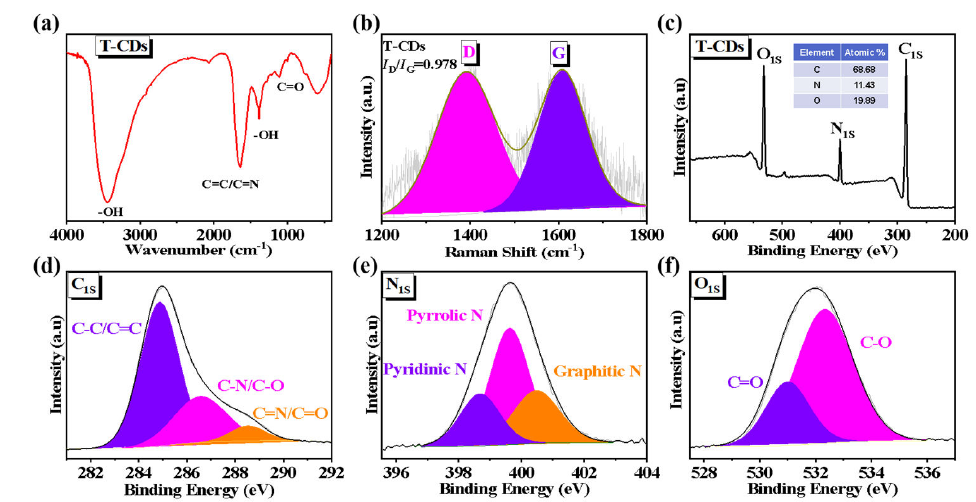
Figure 2. ( a ) FT − IR, ( b ) Raman spectra and ( c ) XPS survey of the T − CDs. XPS high − resolution ( d ) C 1s, ( e ) N 1s and ( f ) O 1s spectra of the T − CDs .